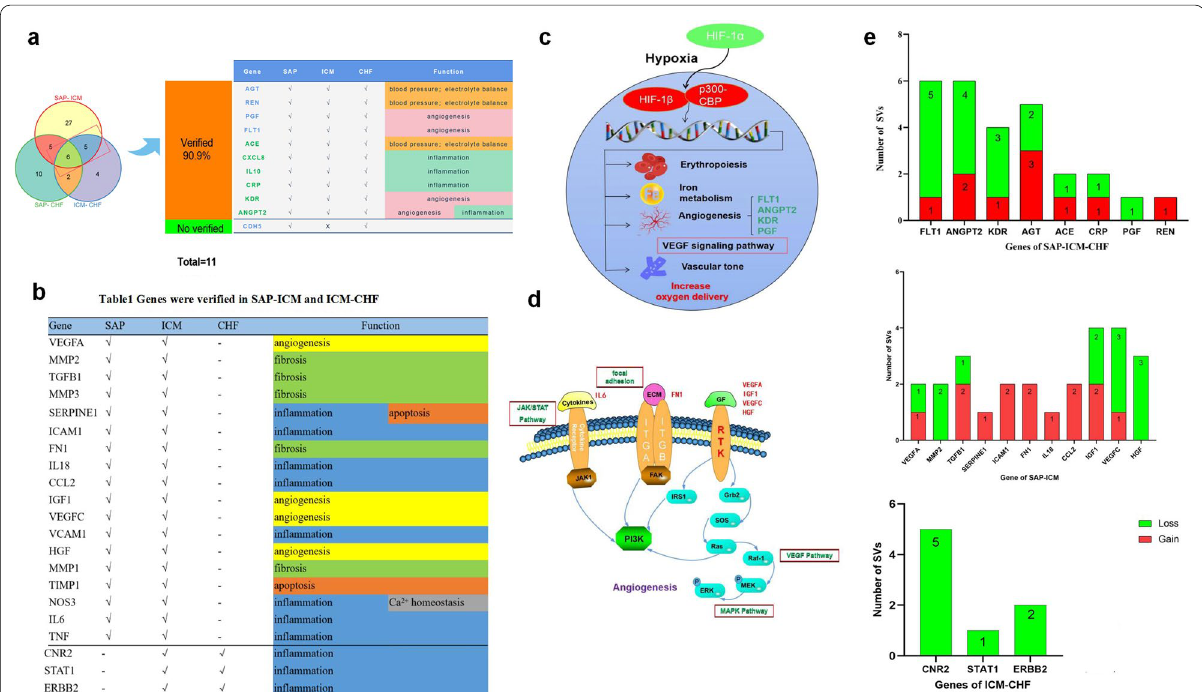
Fig. 6 Literature verification and structural variations of overlapping genes in PDPMs. a Literature validation of overlapping genes in PDPMs. b Literature validation of overlapping genes of SAP–ICM and ICM–CHF in PDPMs. c HIF‑1 signaling pathway and targets involved. d PI3K–AKT signaling pathway and targets involved. e Number of structural variations of verified overlapping genes in